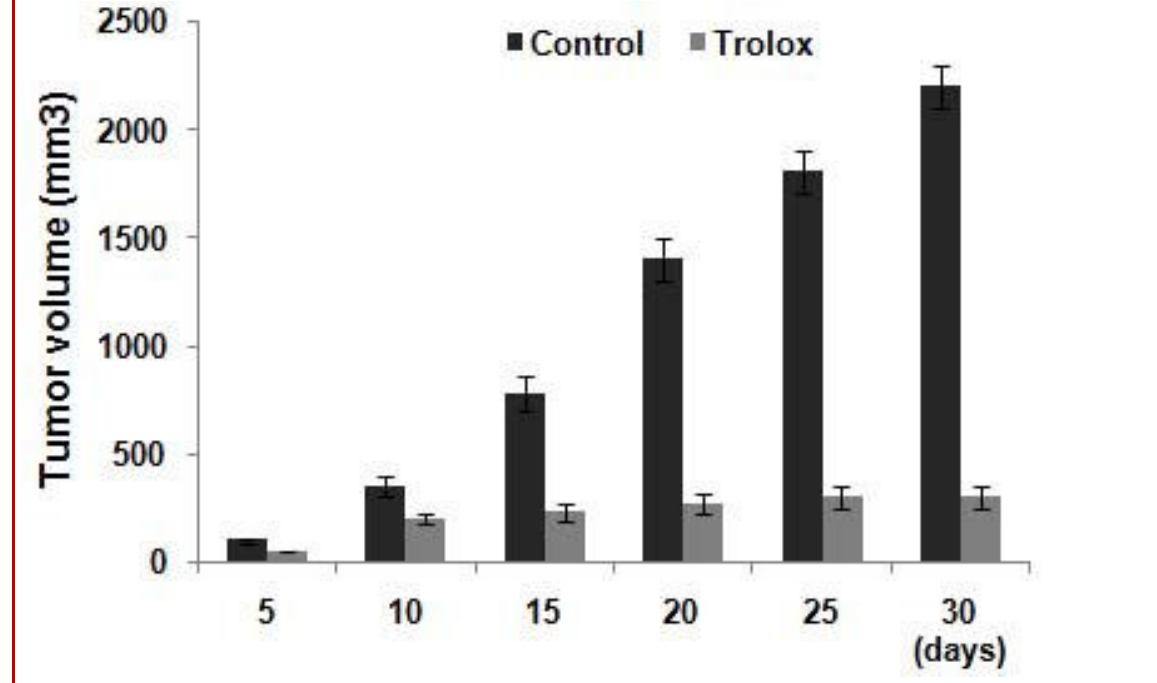
Figure 4: Effect of trolox treatment on the tumor volume of HCT-15 tumor xenograft in mice following 30 days of the